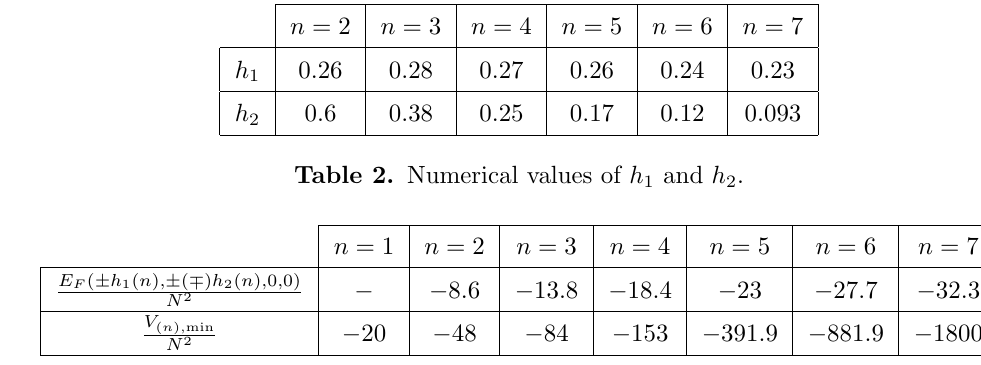
Table 3. Numerical values for E F =N 2 at the critical points ( (cid:6) h 1 ( n ) ; (cid:6) ( (cid:7) ) h 2 ( n ) ; 0 ; 0) and the minimum values of V n